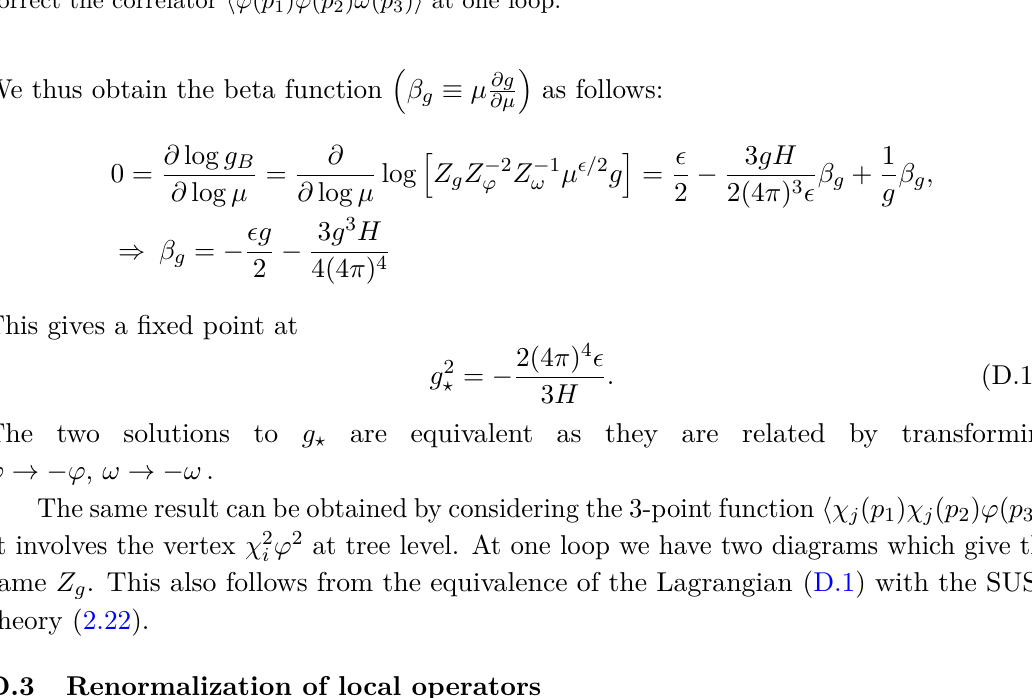
) ϕ ( p ) ω ( p ) i at one 1 2 3